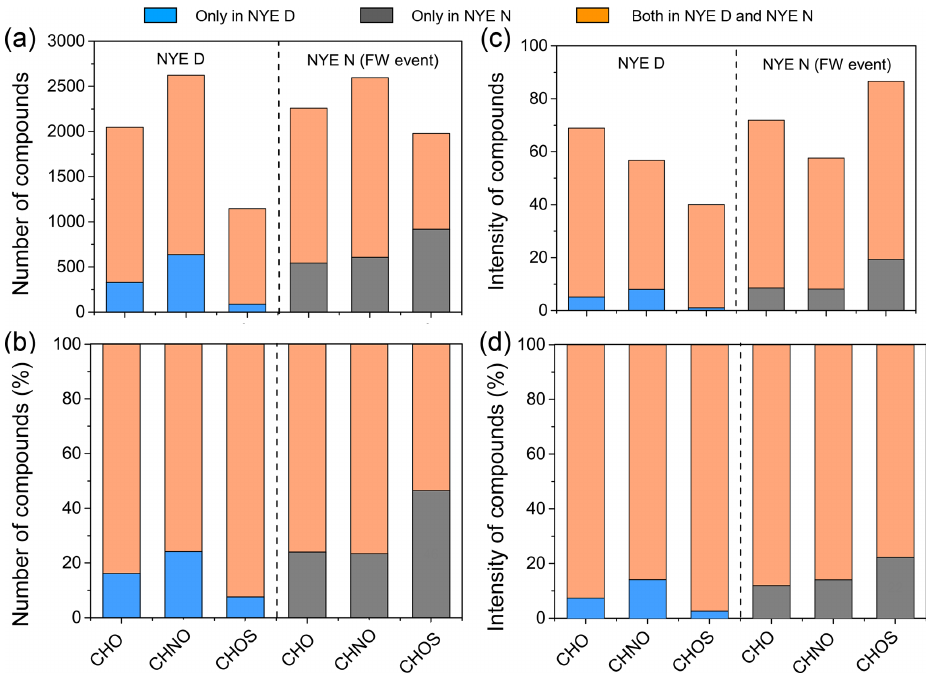
Figure 2. The number (a, b) and intensity (c, d) of molecular formulae associated with three categories of compounds in NYE D (before the FW event) and NYE N (during the FW event) samples, as well as common formulae present at both samples.